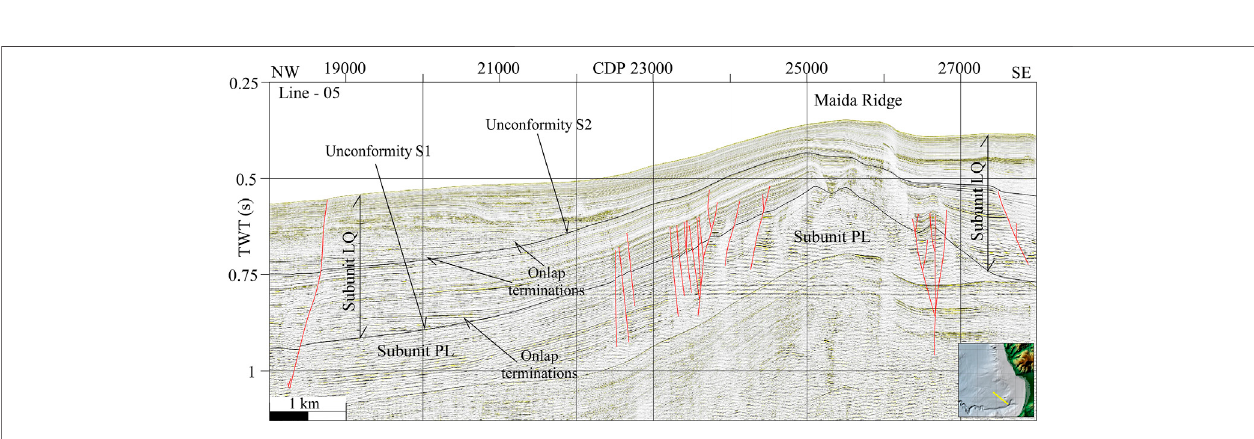
Frontiers in Earth Science |